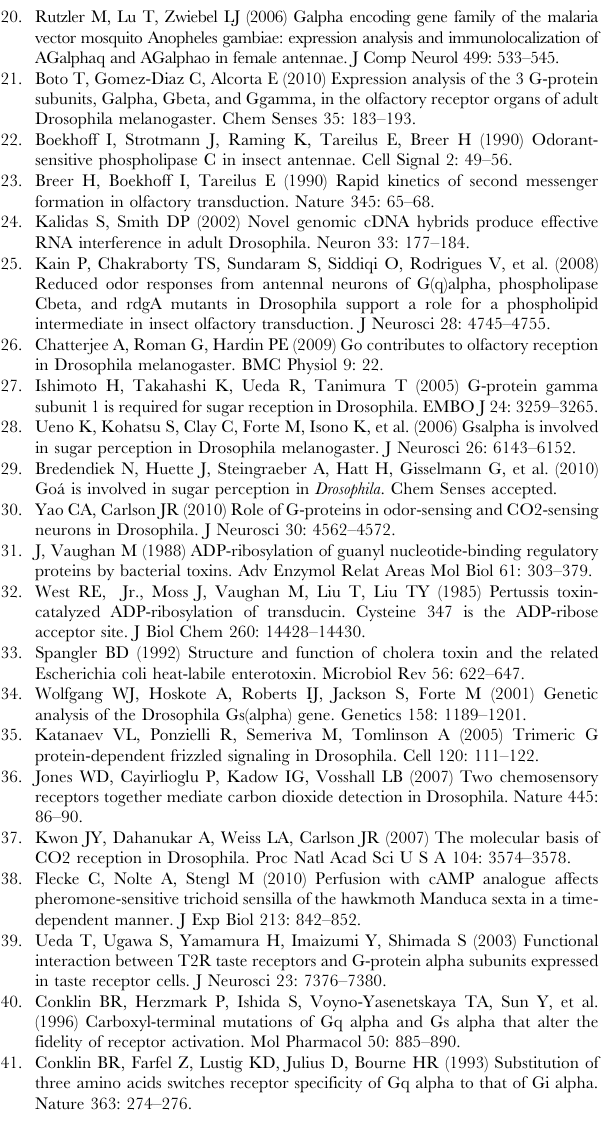
Table S1 G-protein mutant strains used in this study.